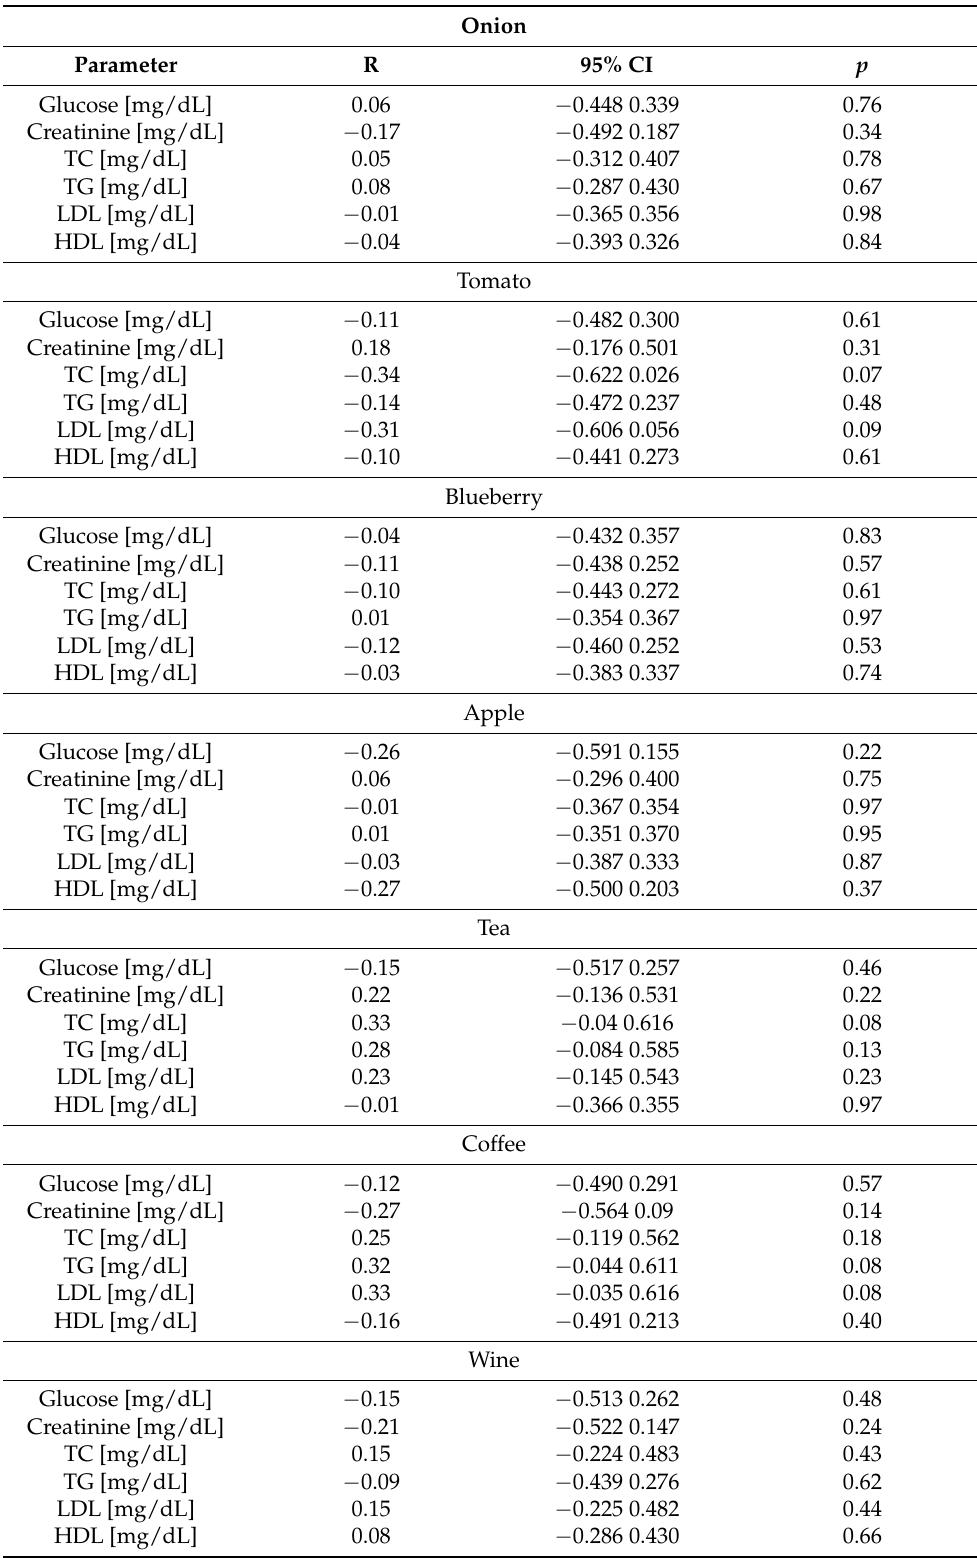
Table 5. Correlation between mean daily consumption of major flavonol sources and laboratory parameters in MetS